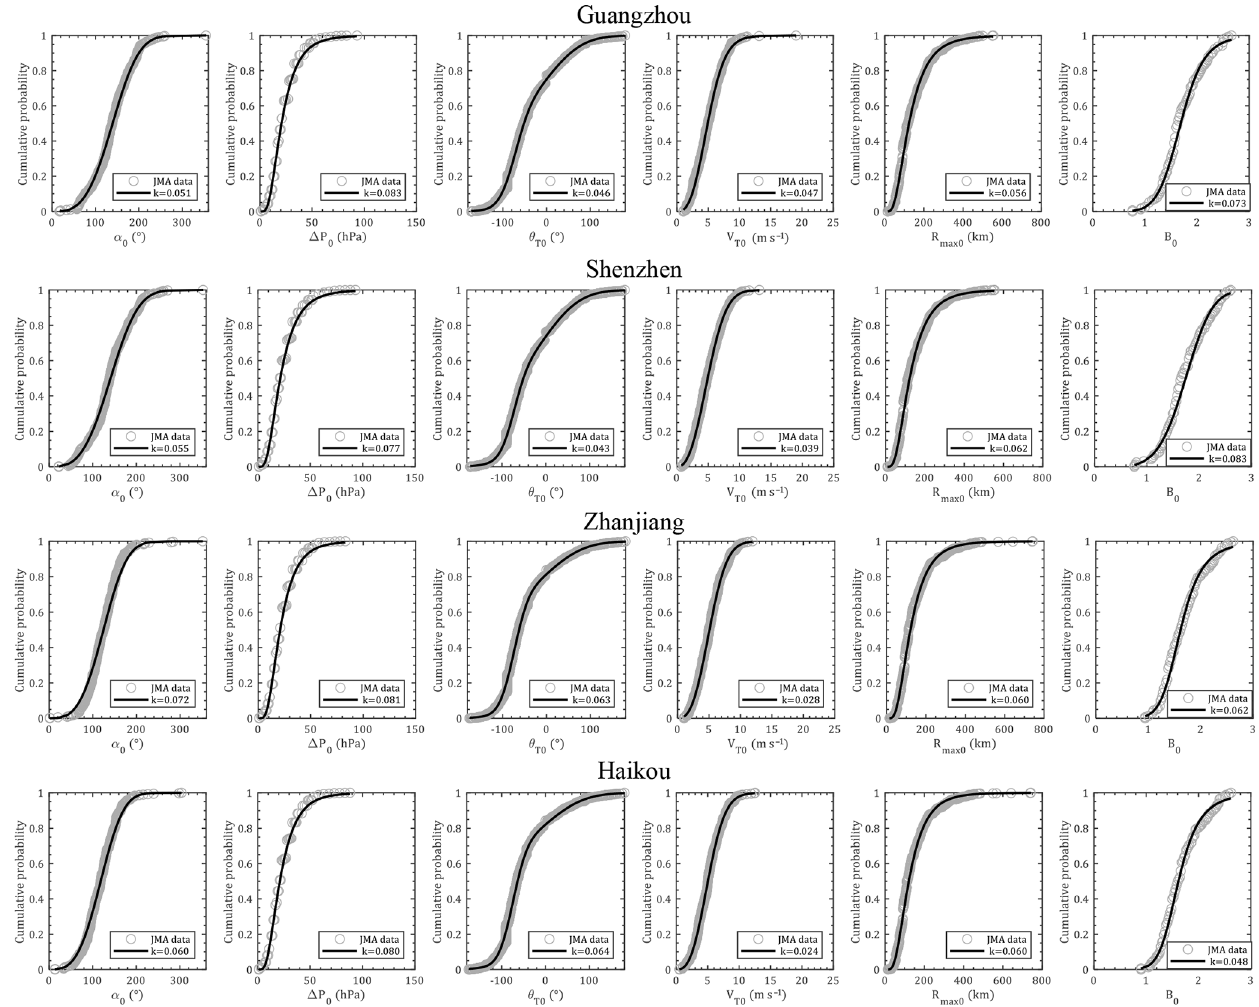
Figure 16. Empirical and preferable cumulative probability distributions for α 0 , (cid:49)P 0 , θ 0 , V T0 , R max , s0 and B s0 .